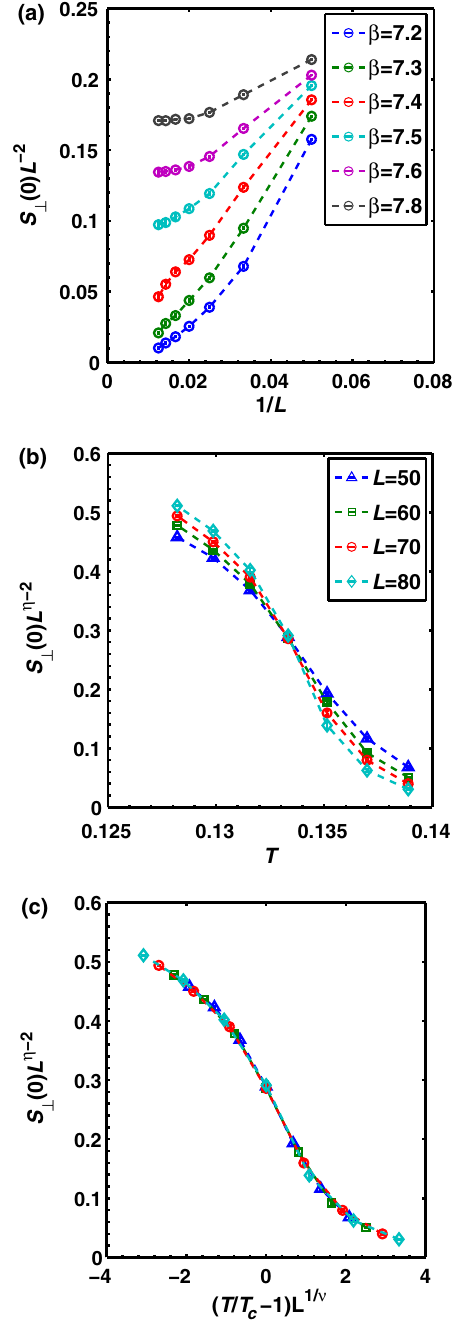
FIG. 7. The FM long-range ordering of the Ising symmetric model with parameters J ⊥ ¼ 2 , J ∥ ¼ 4 , n ¼ 1 , and V ¼ 0 .